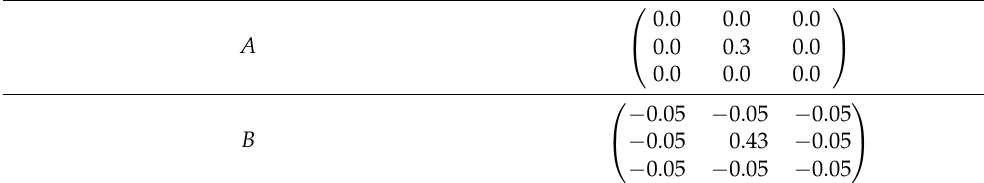
Table 8. Coefficients for the input and output weights in Equation (24) for the case of the image enhancement